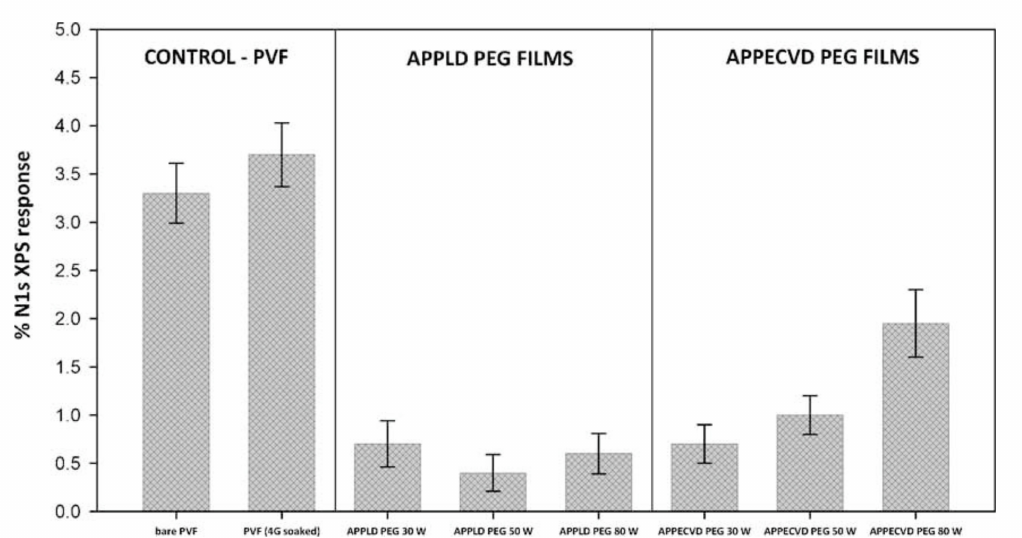
Figure 6. Protein adsorption expressed as X-ray Photoelectron Spectroscopy (XPS) nitrogen atomic percentage of uncoated polyvinylidene fluoride (PVF, control) and coated samples, by aerosol injection (APPLD PEG), or bubbling one (APPE-CVD), after Bovine Serum Albumin (BSA) exposure. Reprinted with permission from [47]. Copyright 2006 John Wiley & Sons, Inc.